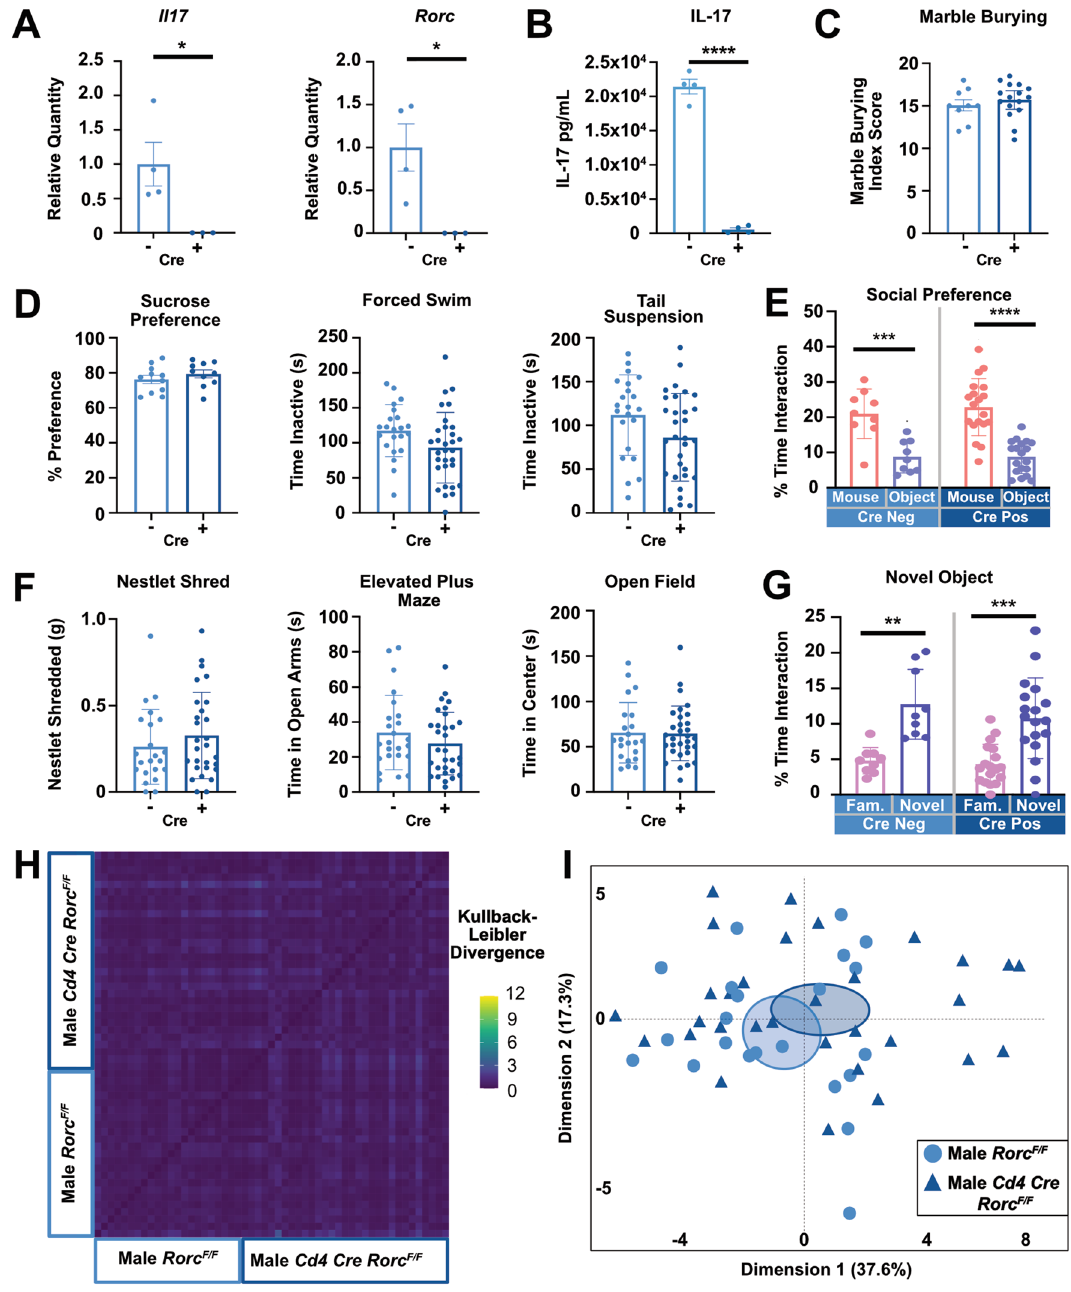
Figure 3. Depletion of Rorc does not Induce Spontaneous Behavioral Changes in Male Mice. ( A ) Loss of gene expression of both Il17 and Rorc in in vitro skewed Th17s from Rorc KO mice and littermate controls by qPCR (n = 3–4/group). T tests ( il17 : p = 0.0450, Rorc : p = 0.0281). ( B ) ELISA representing loss of IL-17 in in vitro skewed Th17s from Rorc KO animals (n = 3–4/group). T test ( p = < 0.0001). ( C ) Baseline marble burying (n = 9 or 16/group), ( D ) sucrose preference (n = 9/group) and forced swim and tail suspension (n = 22 or 37/group), ( E ) social preference (n = 9 or 19/group), ( F ) nestlet shredding (n = 22 or 28/group), elevated plus maze (n = 24 or 31/group) and open field (n = 22 or 31/group), and ( G ) novel object recognition (n = 9 or 19/group) tests. T tests used in D and F. Two-way ANOVA used in E (Cre Neg: p = 0.0010, Cre Pos: p < 0.0001) and G (Cre Neg: p = 0.0014, Cre Pos: p = 0.0002). ( H ) Kullback–Leibler divergence heatmap and (I) PCA plot of DeepLabCut analyzed behaviors between groups (n = 22 or 32/group). Combined N = 2, male